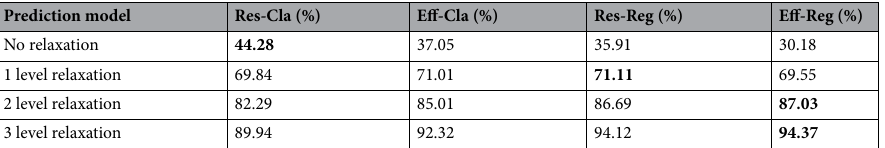
Table 1. The precision of considered BCVA estimation schemes. For each relaxation case, the scheme with the highest precision is highlighted in bold font.